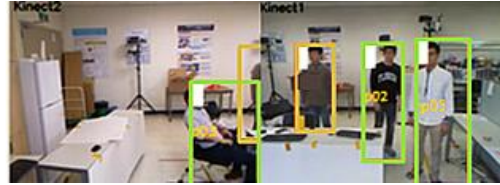
Fig. 5: WHERE fusion of the parallel con(cid:28)guration (keeps correctly 4 detected humans (red ROI rectangular) from total 5 detected humans).